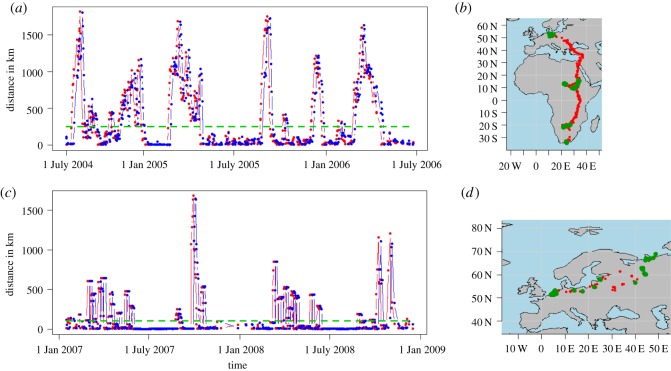
Flight velocities and derived resting locations. (a,c) Time series of daily flight distances of movement towards (red) and from (blue) the best daily bird position at each day, for a selected 2-year track of a white stork (a) and a greater white-fronted goose individual (c). Positions were selected as resting locations when the approaching and departing velocities were smaller than a threshold (horizontal green line) of 50 km d−1 for the stork and 20 km d−1 for the goose. On the maps aside (b,d) the selected breeding, resting and wintering locations are mapped as green dots (red dots depict positions of fast migratory movement) for the individual stork (b) and goose (d).